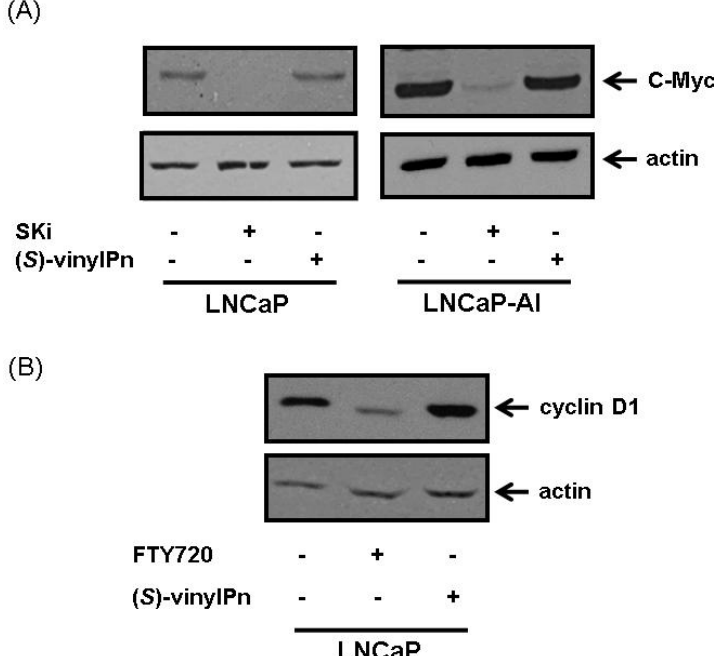
Figure 3. Effect of ( A ) SKi and ( S )-FTY720 vinylphosphonate on c-Myc expression in LNCaP and LNCaP-AI cells. Cells were treated with ( S )-FTY720 vinylphosphonate (50 μM) or SKi (50 μM) with vehicle (DMSO, 0.1% v/v) alone for 18 h. ( B ) FTY720 and ( S )- FTY720 vinylphosphonate on cyclin D1 expression in LNCaP cells. Cells were treated with FTY720 (10 μM, used a positive control) or ( S )-FTY720 vinylphosphonate (10 μM) or vehicle (DMSO, 0.1% v/v) alone for 18 h. The lysates were subjected to western blot analysis with anti-cyclin D1 or actin antibodies. Results are representative of at least